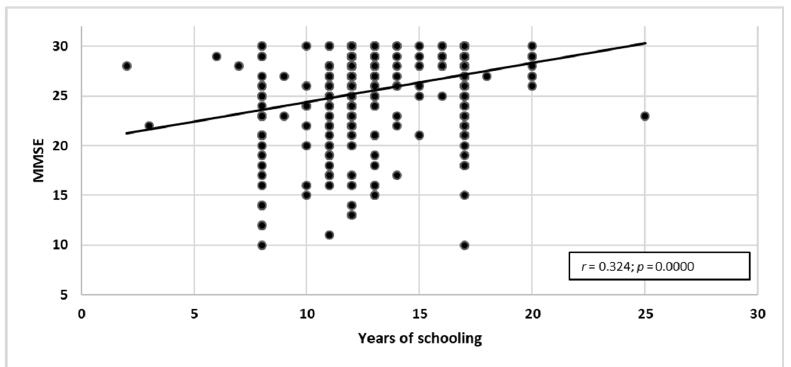
Figure 2. Years of schooling correlated with raw MMSE data.